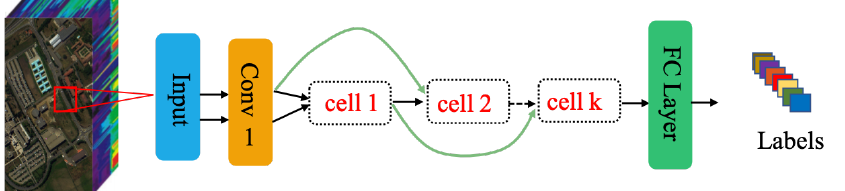
Figure 3. The general architecture stacking by the automatically designed computation cells by PSO-Net and CPSO-Net. The bottleneck convolution layer and the fully connected layer in Figure 3 are designed for data preprocessing and classification with human knowledge.